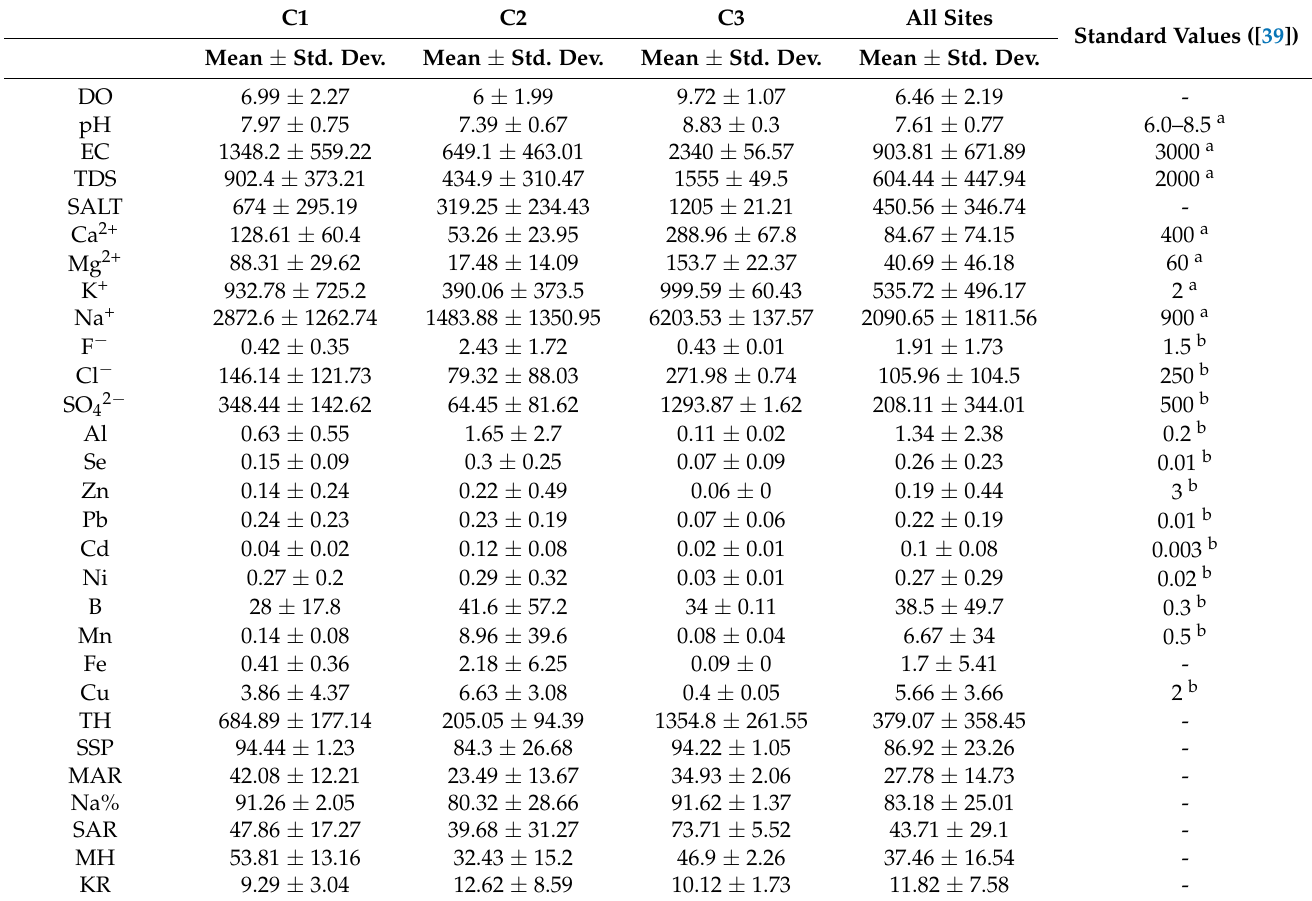
Standard Values ([39])